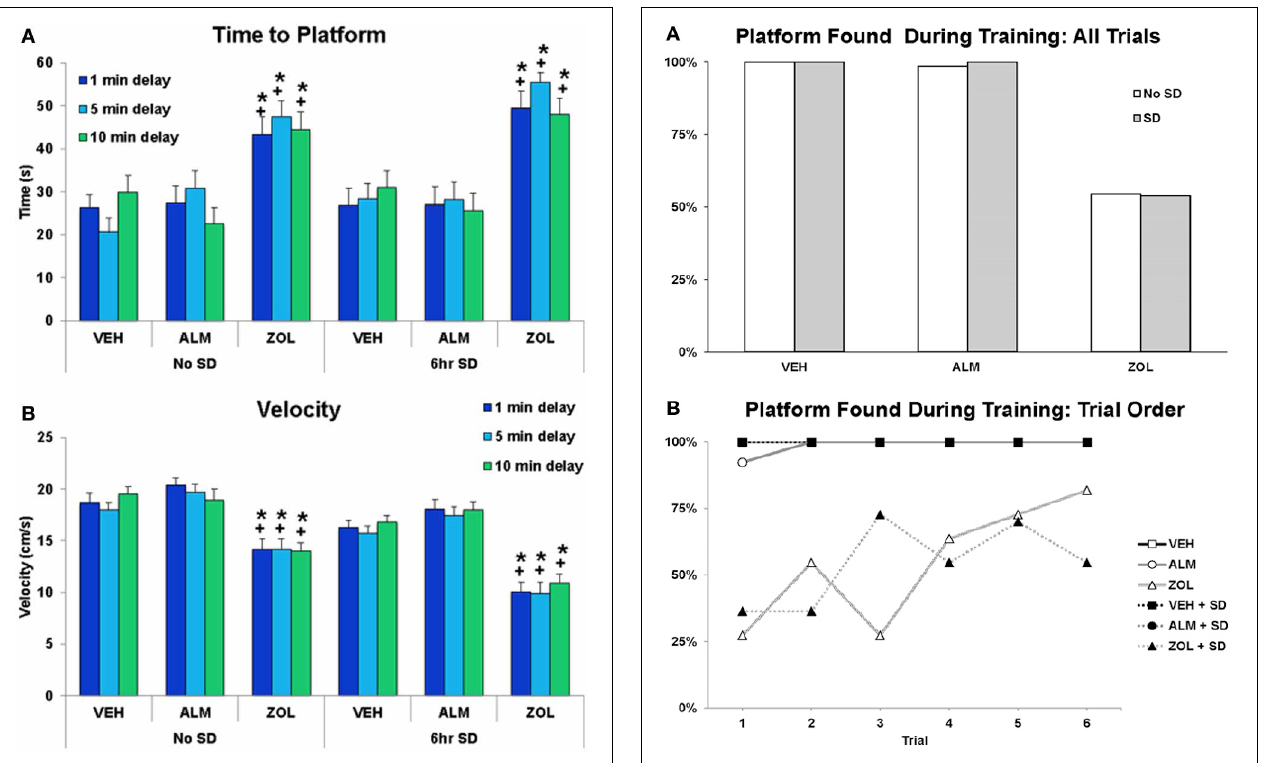
FIGURE 5 | The time to platform and the velocity swam during the spatial working memory task. (A) ZOL-treated rats found the platform significantly slower than VEH- or ALM-treated rats for all three delays following either undisturbed or SD conditions. The ALM-treated rats were not significantly different from VEH-treated rats for any condition. (B) ZOL-treated rats swam more slowly than either VEH- or ALM-treated rats. ∗ , different from VEH; + , different from ALM; p < 0 . 05.